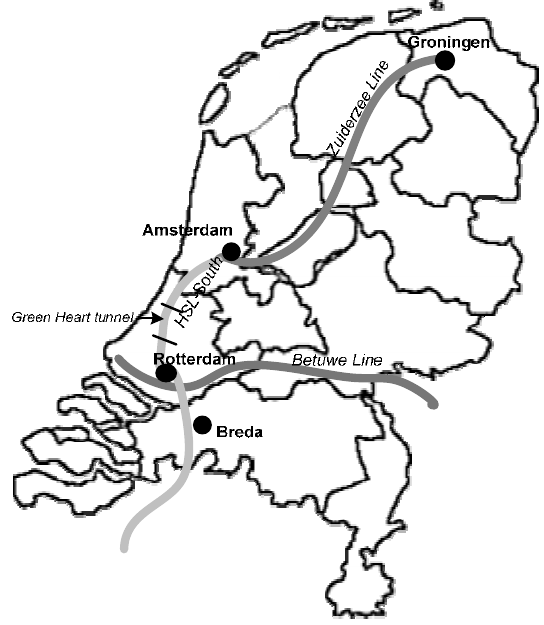
Figure 1. Indication of the three projects in the